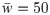
Results on random and scale free networks.Top: The distribution of average wealth 〈wz〉 vs. opportunities z for a random network with N = 1000 nodes and p = 0.1 probability of connection (thus average wealth w¯=50) at T = 1, obtained via Metropolis simulation (in red the mean field formula). The left (right) inset represents the distribution of average frustration 〈fz〉 (motivation mz) vs. opportunities z. The bars denote fluctuations in wealth (and frustration) among agents endowed with the same opportunities due to the topological structure of the graph. Bottom: Same figures for a Barabàsi-Albert graph with minimum coordination m=w¯=50 in a finite system (N = 5000 nodes) in the thermodynamic limit at T = 0.1. The green line describes the wealth allocation obtained by using P(z′|z) for the scale free network (reported in Methods) in the limit of a large society. Here, however, finite size effects cause a deviation of ∼ 5 × 10−4 agents among the richest. The red line is obtained via the mean field treatment using the actual conditional probability of the finite system, numerically generated, and reproduces the numerical results even better.